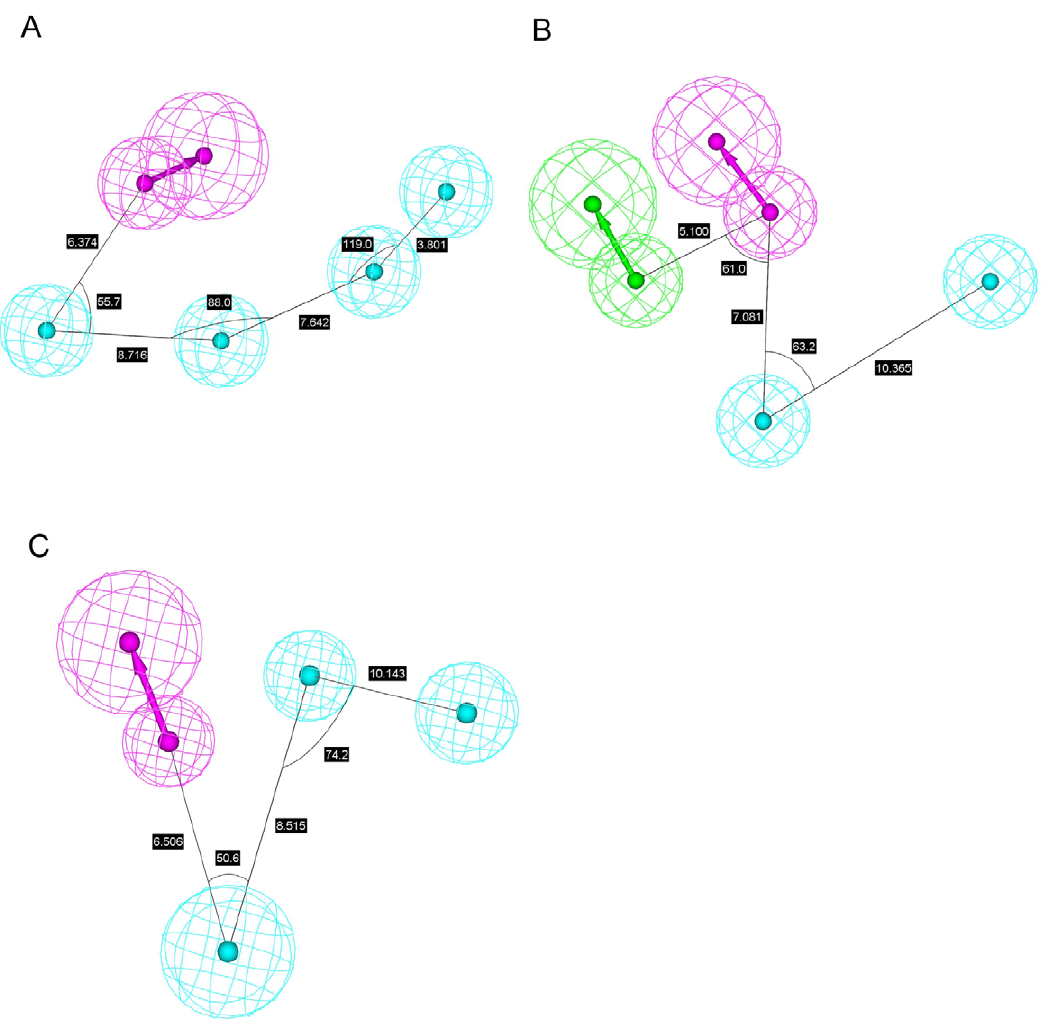
Figure 2. Pharmacophore models in the ensemble. Generated pharmacophore models (A) Hypo A, (B) Hypo B and (C) Hypo C, in which hydrophobic, hydrogen-bond acceptor and hydrogen-bond donor features are represented by light blue blobs, magenta blobs and arrows, and green blobs and arrows, respectively. The interfeature distances and angles among features, depicted in white, are measured in A˚ngstroms and degrees, respectively.